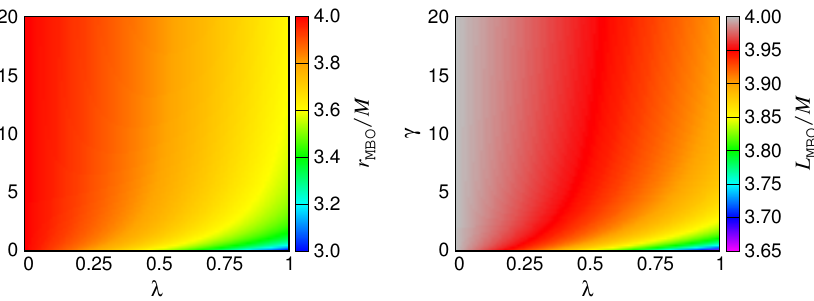
Figure 2. r MBO / M and L MBO / M of a timelike particle around RGISBHs with respect to λ and γ .